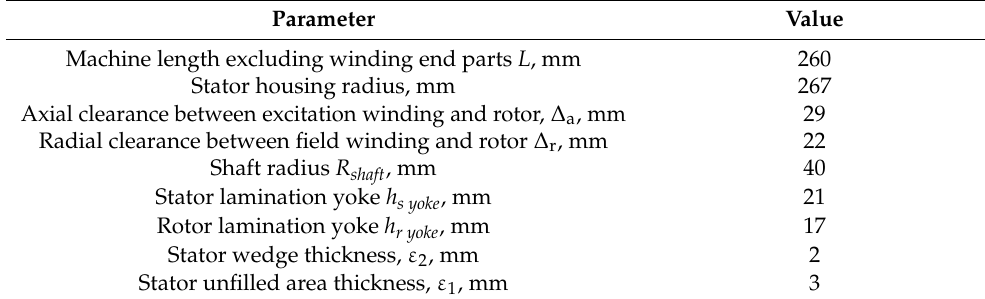
Table 3. Motor parameters unchanged during optimization. Parameter Value Machine length excluding winding end parts L , mm 260 Stator housing radius, mm 267 Axial clearance between excitation winding and rotor, ∆ a , mm 29 Radial clearance between field winding and rotor ∆ r , mm